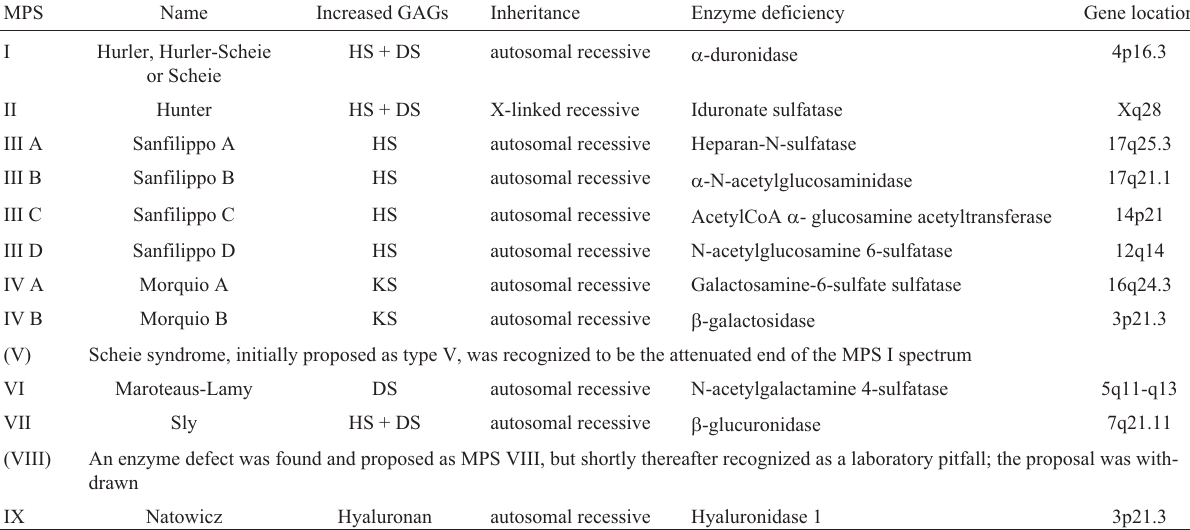
Table 1 - Classification of